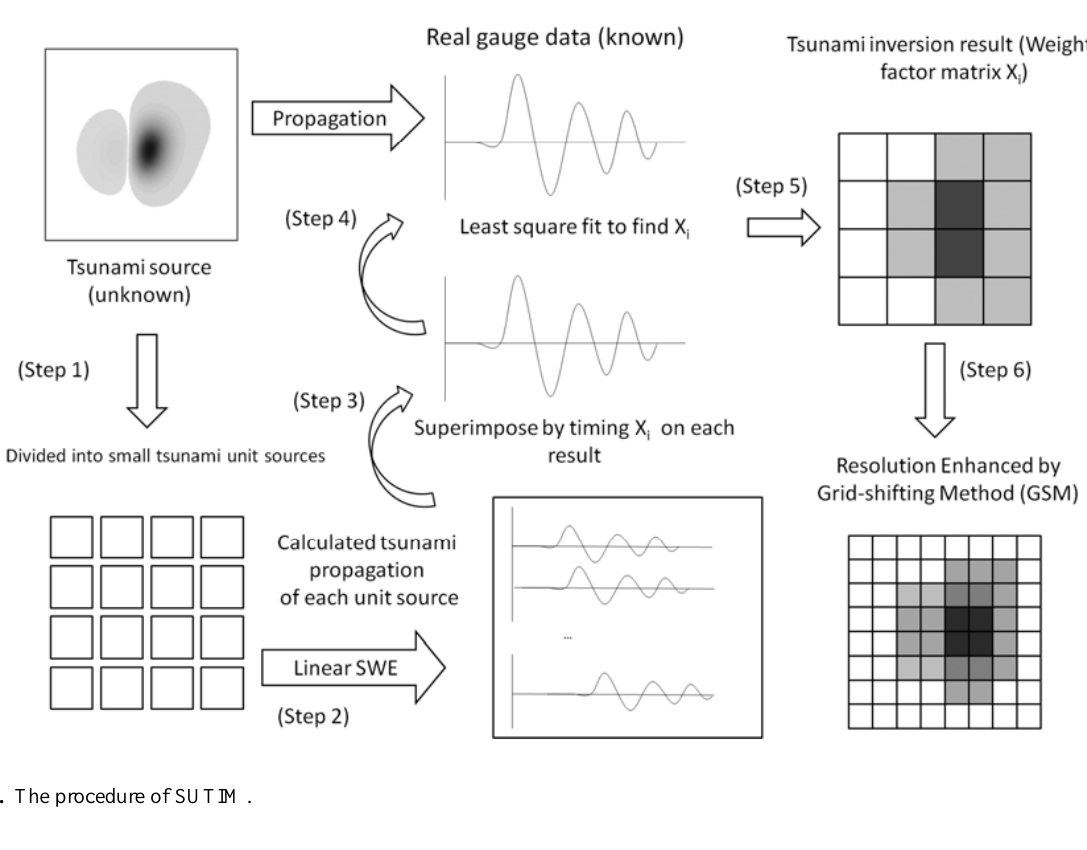
Fig. 1. The procedure of Figure 1. The procedure of SUTIM. 3